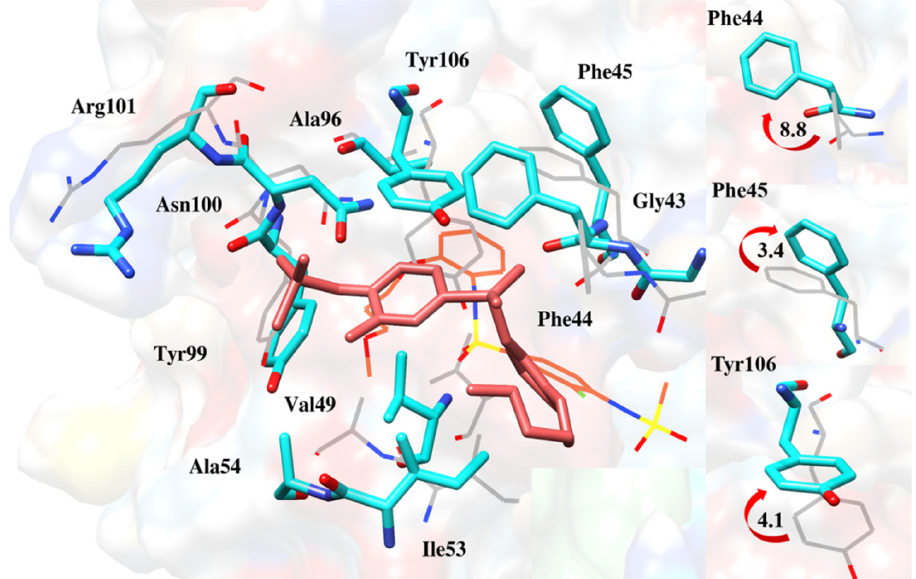
Figure 14. Comparison of docking and MD-averaged poses of BRD9-ZINC433599781 to highlight the deflection of Phe44, Phe45 and Tyr106 [17].